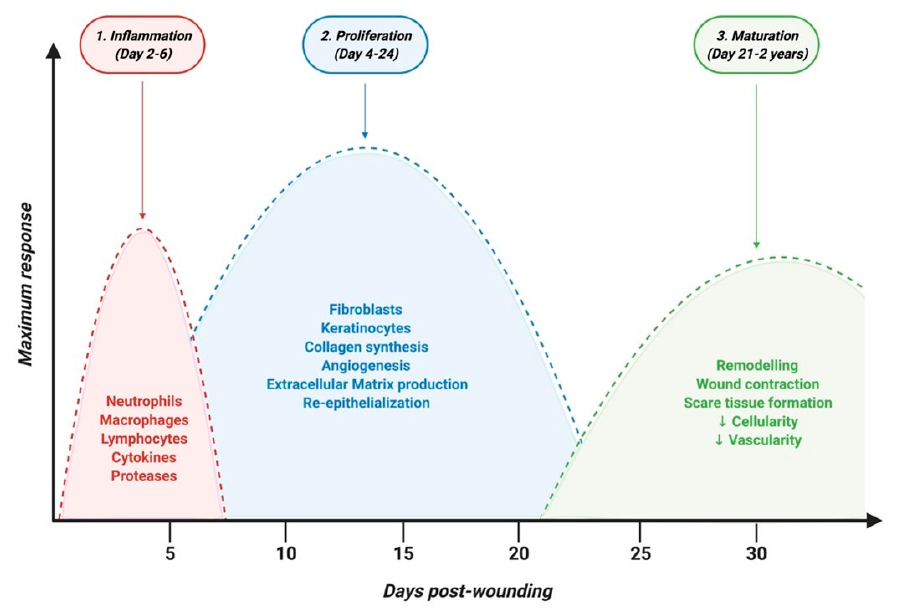
Figure 2. Timeline of physiological skin wound healing phases.